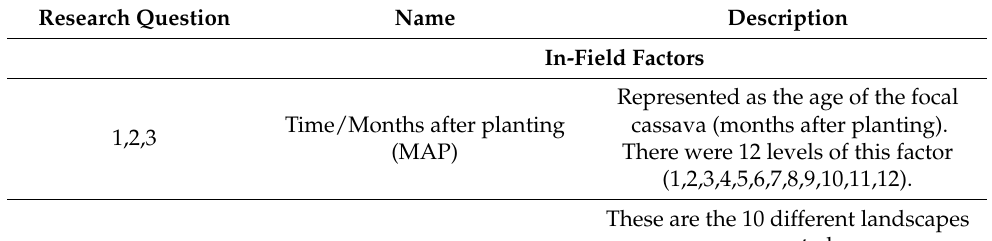
Table 1. Predictor or explanatory variables and the research questions they were used to address in the data